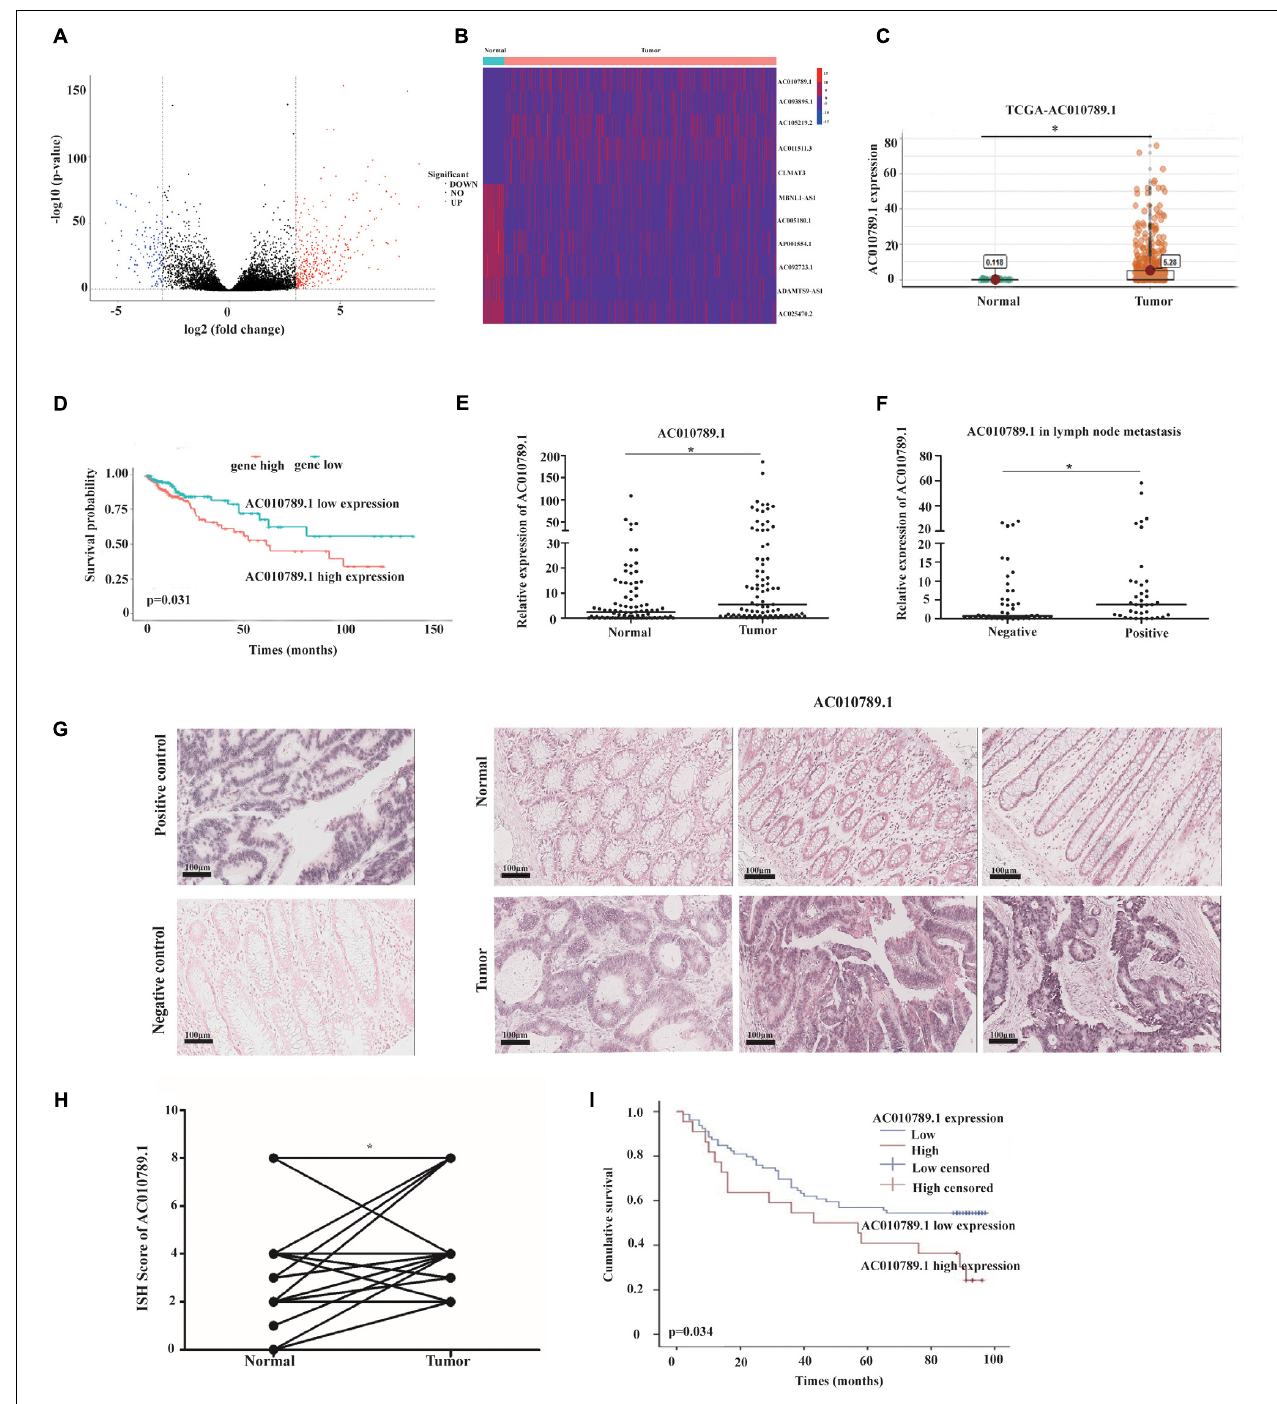
FIGURE 1 | AC010789.1 is upregulated in CRC tissues, and its overexpression correlates with poor outcome of CRC. (A) Volcano plot of expression changes greater than triple of lncRNAs in CRC and normal tissues. (criteria: P < 0.05 and | log2FC| > 3). (B) Heat map of lncRNAs that were abnormally expressed and associated with prognosis in CRC (criteria: P < 0.05). (C) AC010789.1 expression level in CRC tissues ( n = 647) and normal tissues ( n = 51) analyzed using the TCGA database. (D) Kaplan-Meier analysis of the overall survival of CRC patients with high and low levels of ACO10789.1 using the TCGA database. (E) Expression level of AC010789.1 in an additional CRC tissues ( n = 86) and normal tissues ( n = 86) were detected by qRT-PCR. (F) Relative expression level of AC010789.1 in CRC with lymph node metastasis ( n = 37) and non-lymph node metastasis ( n = 49). (G) ISH analysis of AC010789.1 expression in CRC tissues ( n = 76) and normal tissues ( n = 76) (Positive control, U6; negative control, scrambled lncRNA control), Scale bar: 100 µ m. (H) ISH analysis of AC010789.1 expression in CRC and paired normal tissues. (I) Kaplan-Meier analysis for overall survival of CRC patients with low and high AC010789.1 expression ( P = 0.034), * P < 0.05.